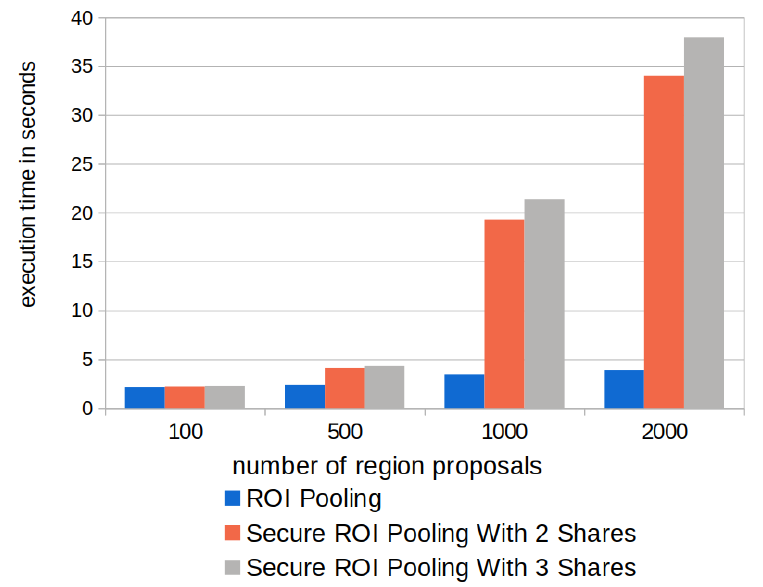
Figure 6. Execution time of the secure ROI pooling in vePOD Faster R-CNN for processing different numbers of region proposals.